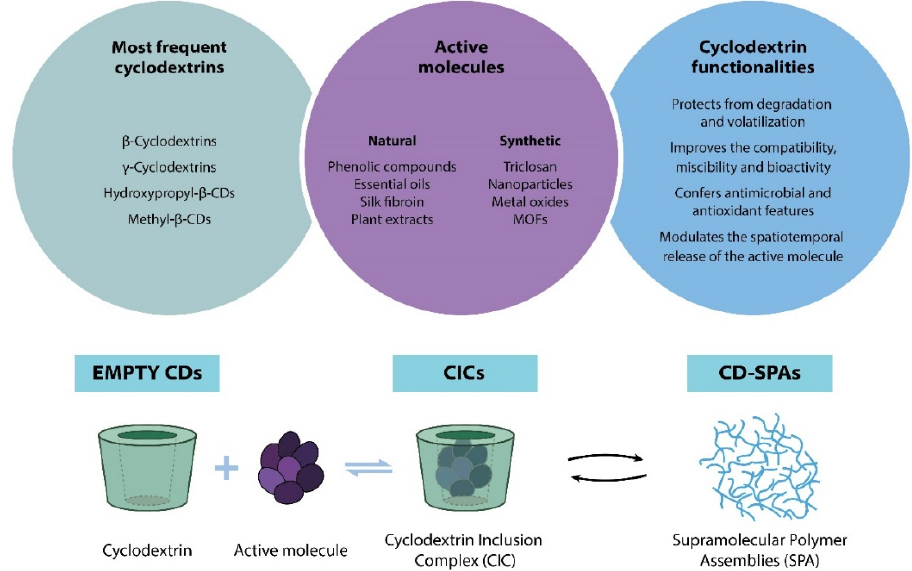
Figure 5. Schematic representation of the cyclodextrin inclusion complex (CIC) formation. The most frequent CICs, the active molecules, and the main CD functionalities for active packaging applications (AFP) are also listed.